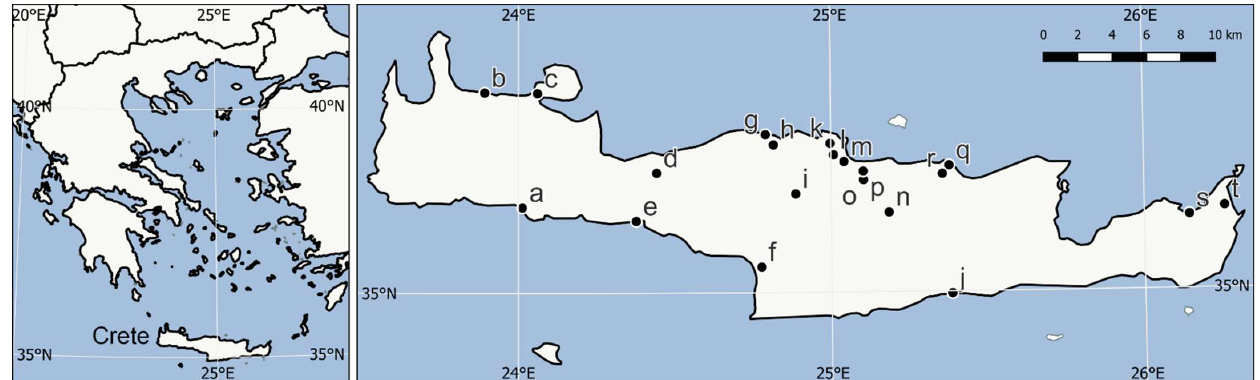
Figure 1. Private and public green spaces with an area of more than two acres that participated in the research evaluation of uses of native Mediterranean plants in landscape architecture. Shown green spaces (year of establishment) are: a. SPGS (2001), b. PGS (1997), c. HMU (2021), d. HMU (2021), e. PGS (2000), f. PGS (1998), g. PGS (1996), h. SPGS (1997), i. PubGS (2018), j. PGS (1997), k. and l. SPGS (1999), m. PGS (1996), n. PGS (1998), o. PGS (2002), p. HMU (2001), q. SPGS (1998), r. PubGS (2000), s. HMU (2021) and t. PGS (1999), where PGS: undisclosed private green space SPGS: undisclosed shared private green space (e.g., hotel, apartment, restaurant), PubGS: public green space, HMU: Hellenic Mediterranean University.